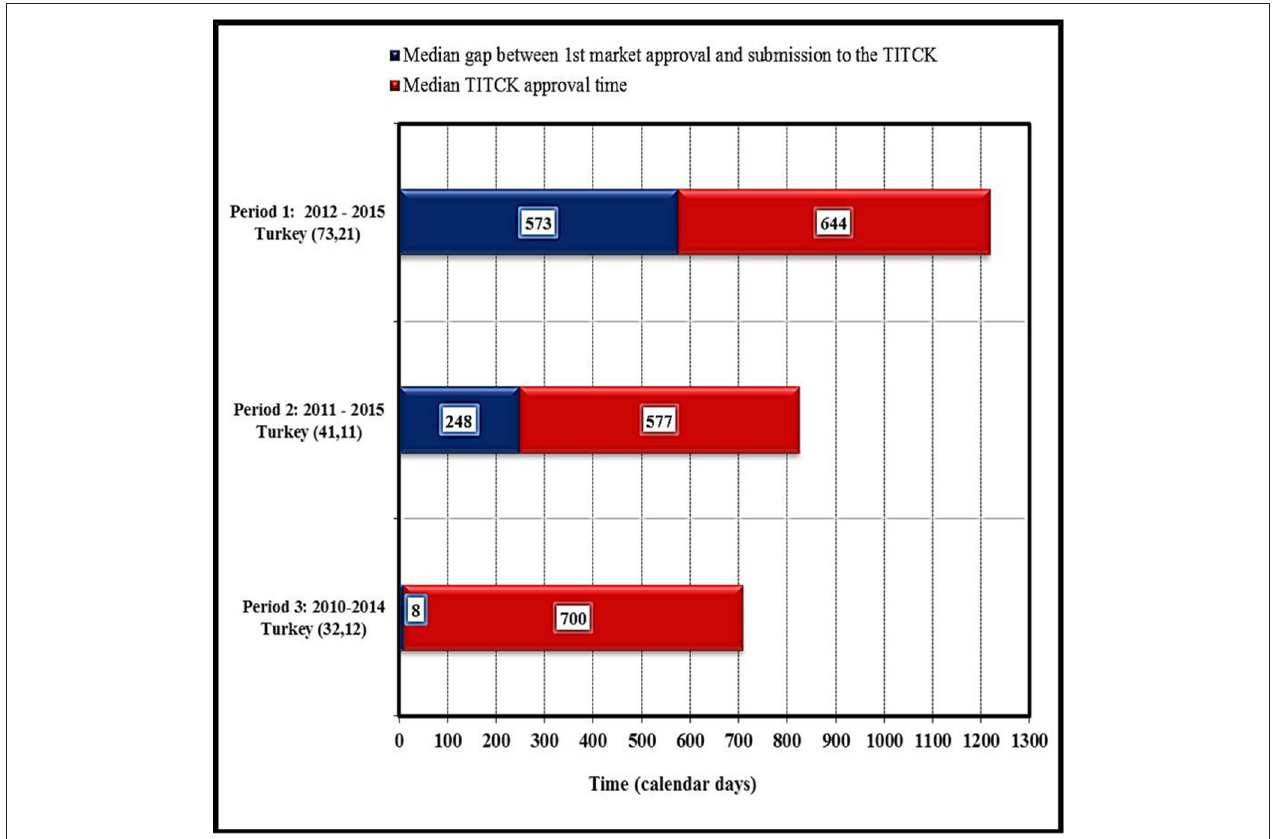
FIGURE 6 | Impact of current good manufacturing processes on approval timelines of NASs by TITCK (industry